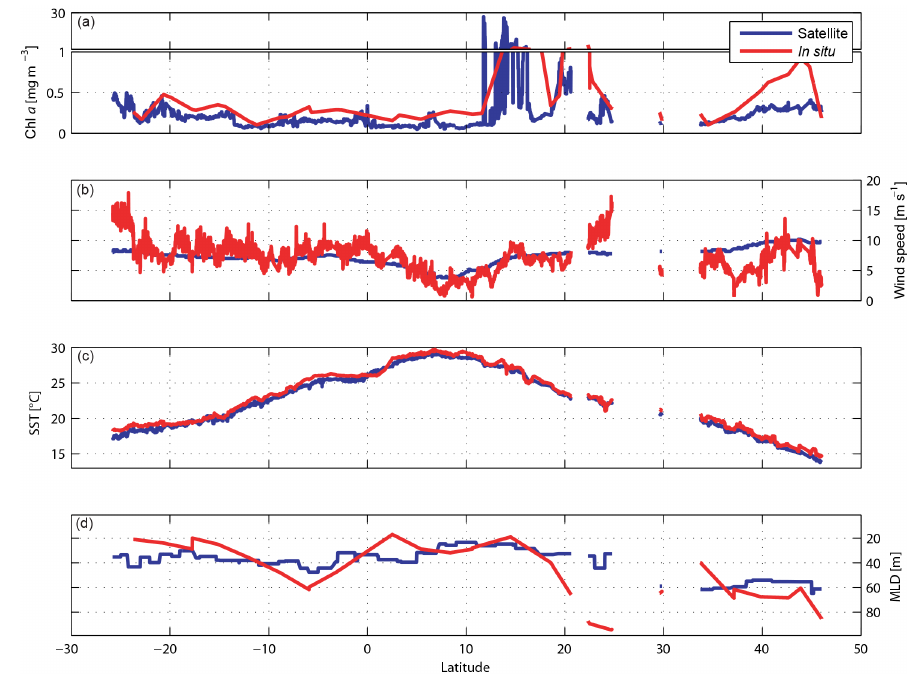
Figure 3. Satellite and in situ data for the ANT-XXV/1 cruise. Monthly mean satellite-derived data (blue) and in situ measurements (red) of (a) chl a , (b) wind speed, (c) SST, and (d) monthly mean climatology values (blue) and in situ measurements (red) of